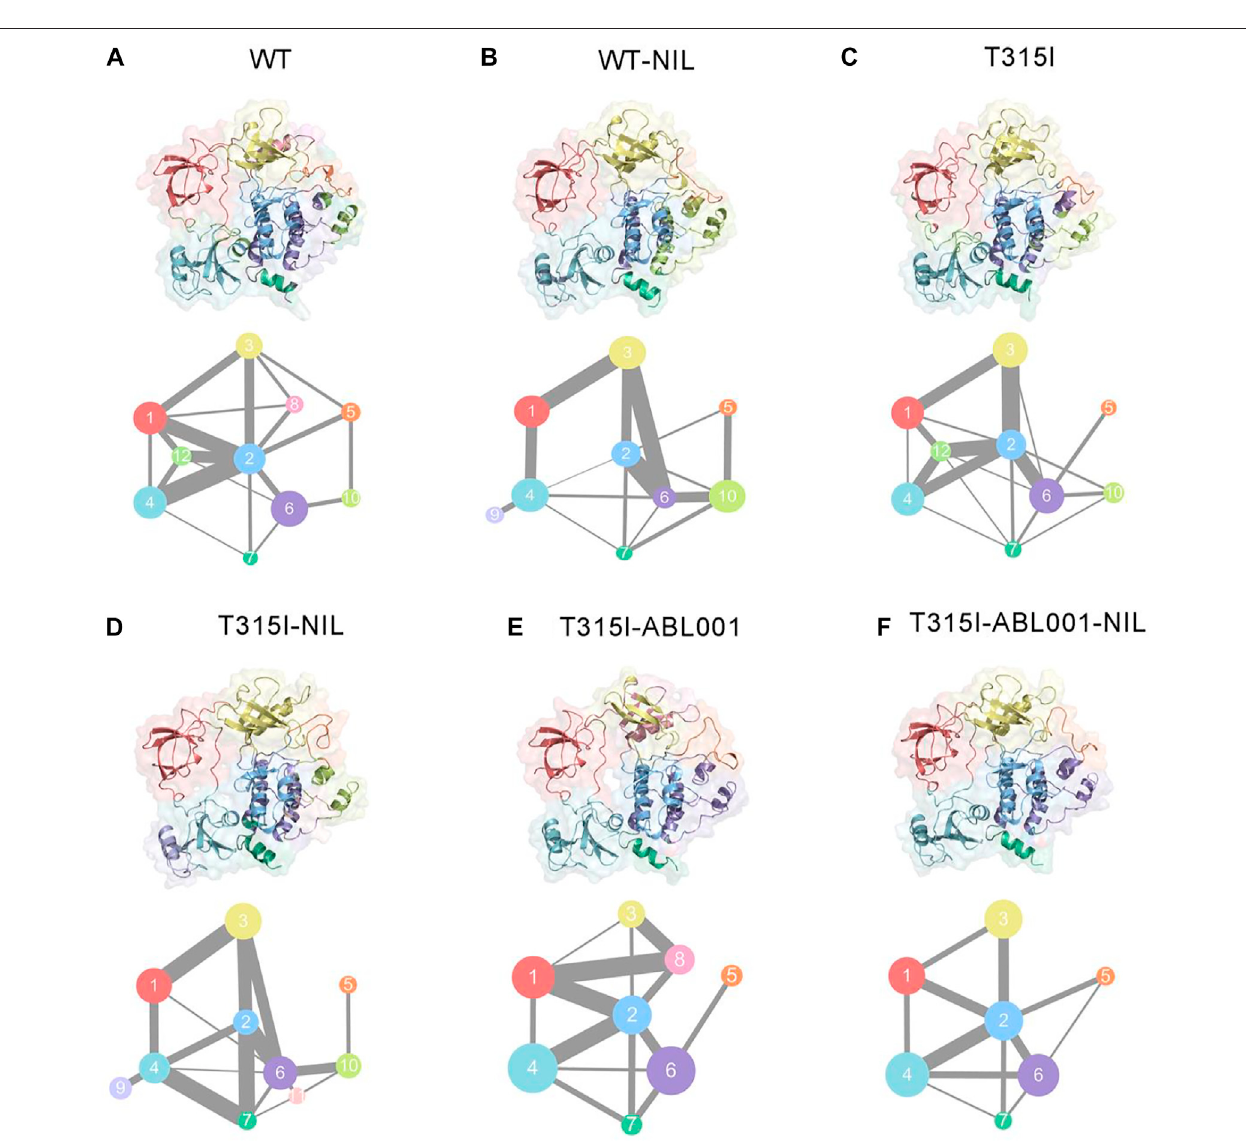
FIGURE5| ColoredcommunitynetworksofWT (A) ,WT-NIL (B) ,T315I (C), T315I-NIL (D) ,T315I-ABL001 (E) ,andT315I-ABL001-NIL (F) .Eachspherestandsfor an individual community with an area proportional to the number of residues it contains. While the lines connecting different spheres visualize the inter-community connections, and the thickness of these lines is proportional to the corresponding edge